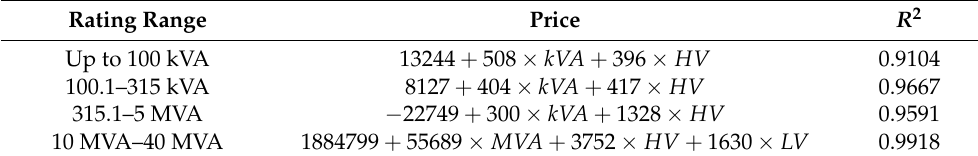
Table 6. Proposed regression models for the transformer purchase